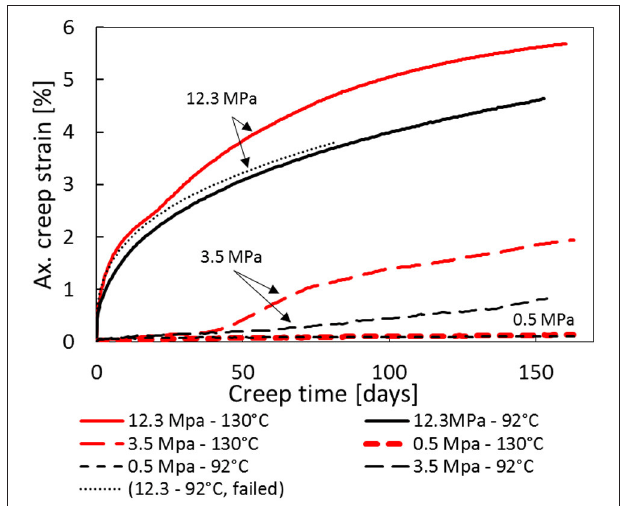
FIGURE 3 | Axial creep strain curve with time for 130and 92 ◦ C temperatures, and 0.5, 3.5, and 12.3MPa effective stresses. In addition, a failed test performed at 12.3 and 92 ◦ C is included to display the repeatability of creep experiments.